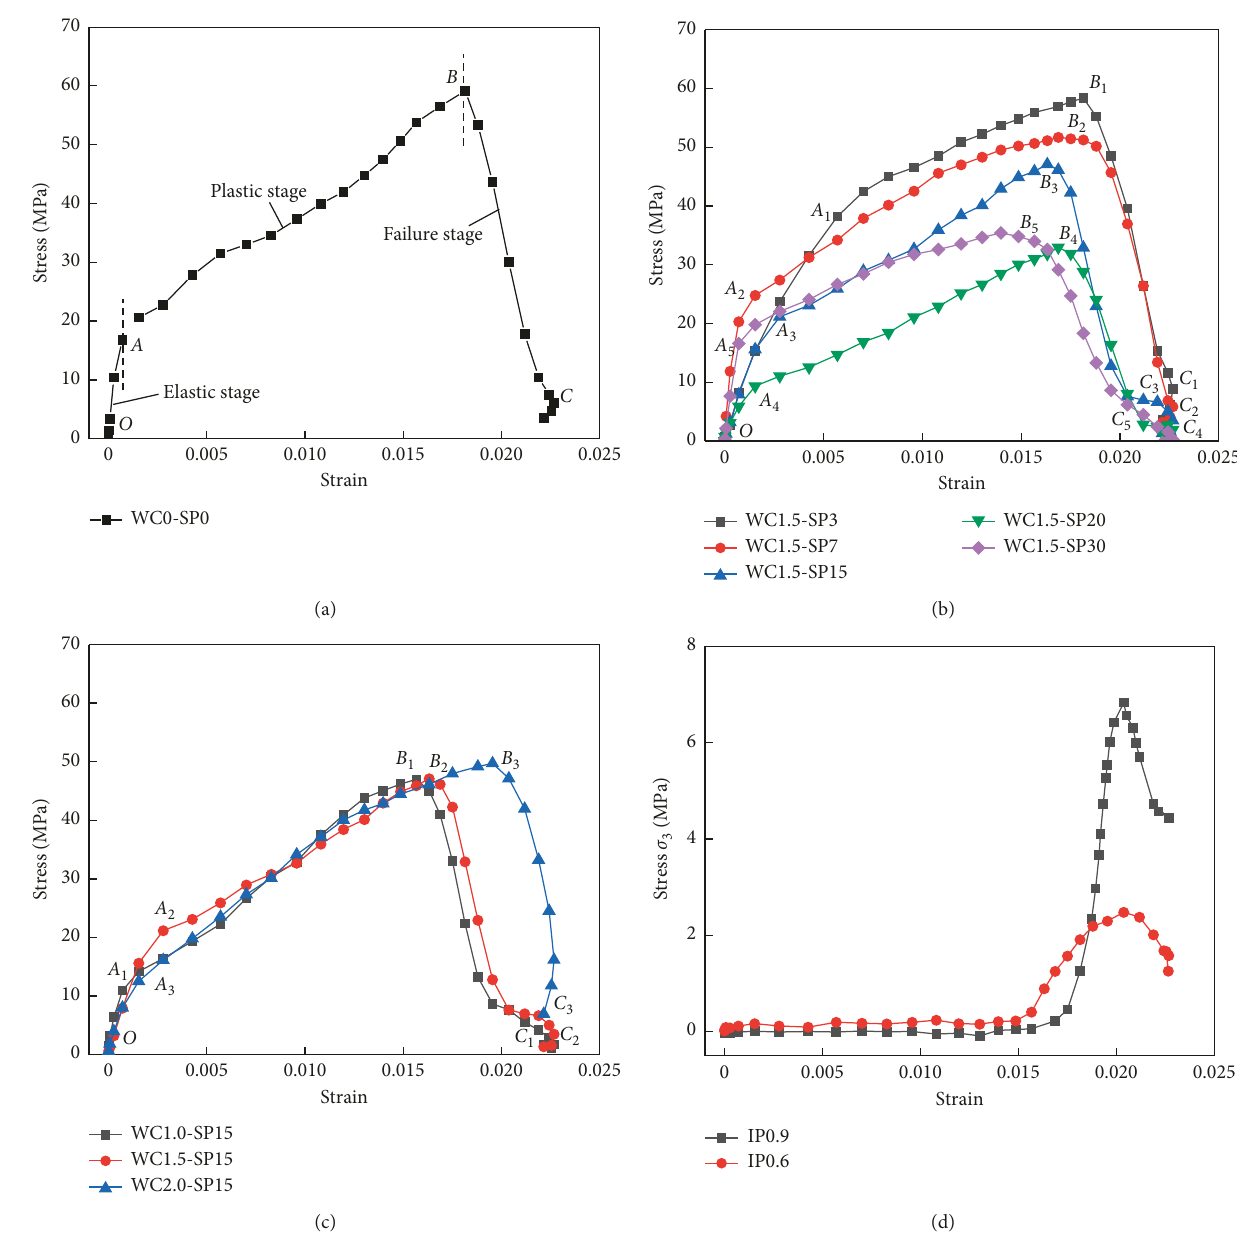
Figure 11: Dynamic stress-strain curves for ready-mixed concrete with 0.9MPa impact pressure in passive confining pressure